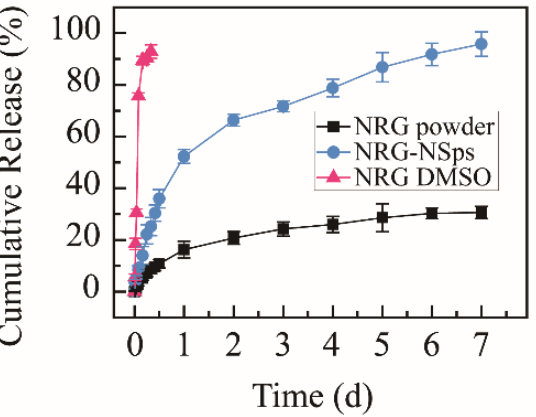
Figure 3. Cumulative release curves of NRG-NSps, NRG powder, and NRG DMSO solution in PBS (pH 7.4) at 37 ◦